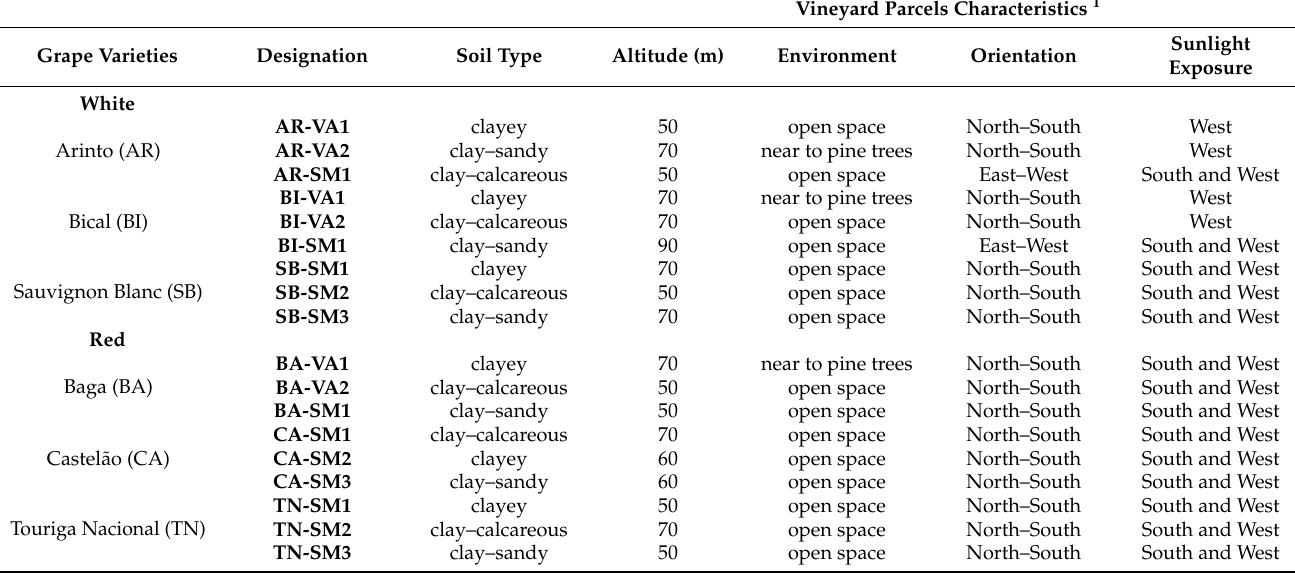
Table 1. Main characteristics of the vineyard parcels where the six Vitis vinifera varieties were collected. Vineyard Parcels Characteristics